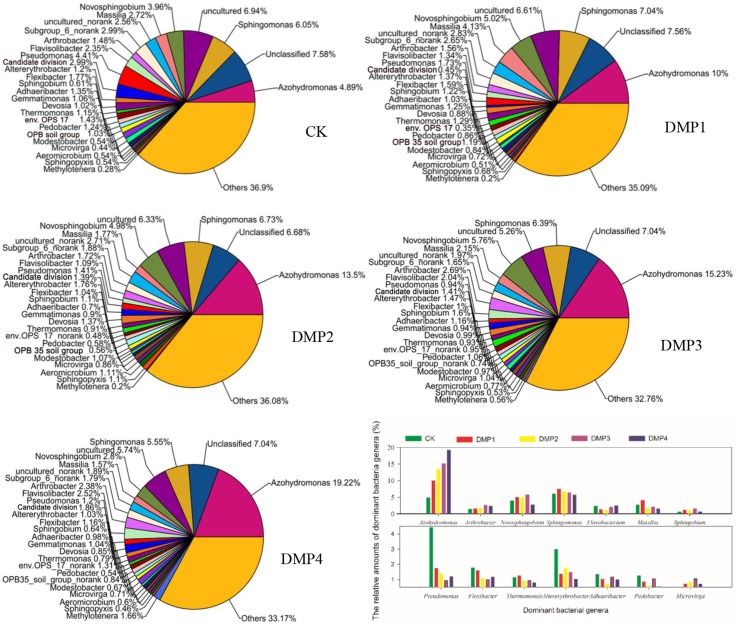
The comparisons among the community structures and relative abundances of the microbial genera recovered from black soils and incubated for 25 days in the dark at 25°C and 70% relative humidity. DMP concentration varied from 0 to 40 mg/kg soil (CK, DMP1, DMP2, DMP3, and DMP4).